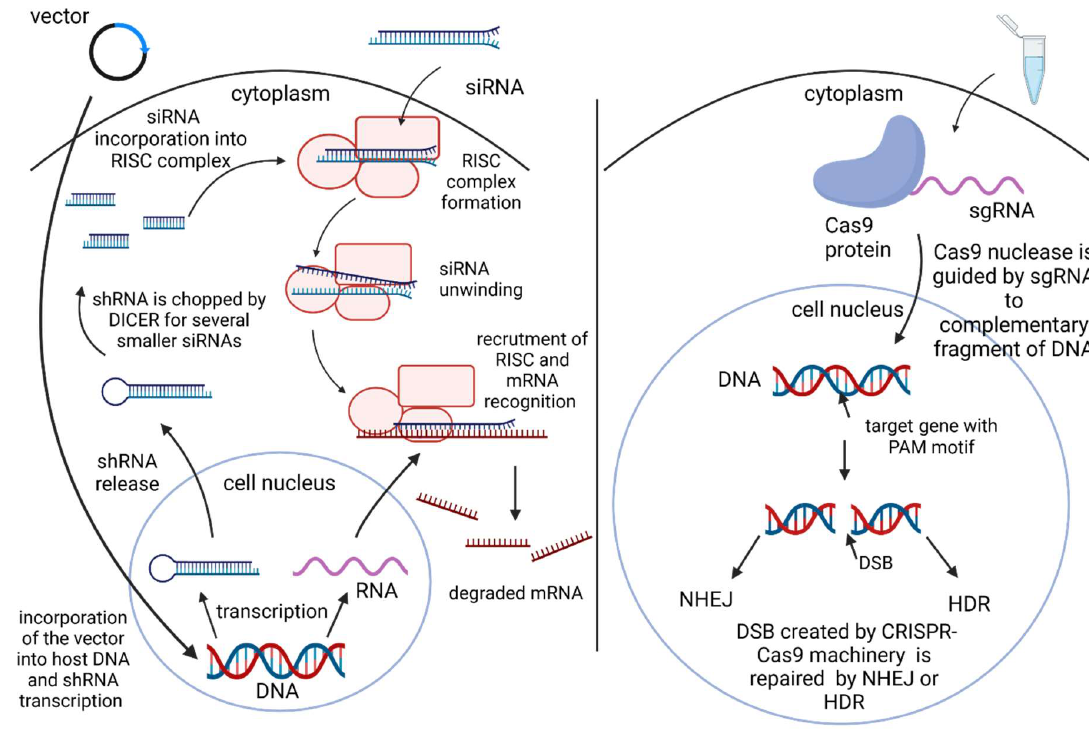
Figure 2. The RNA interference mechanism and CRISPR-Cas9 mechanism in human cell.